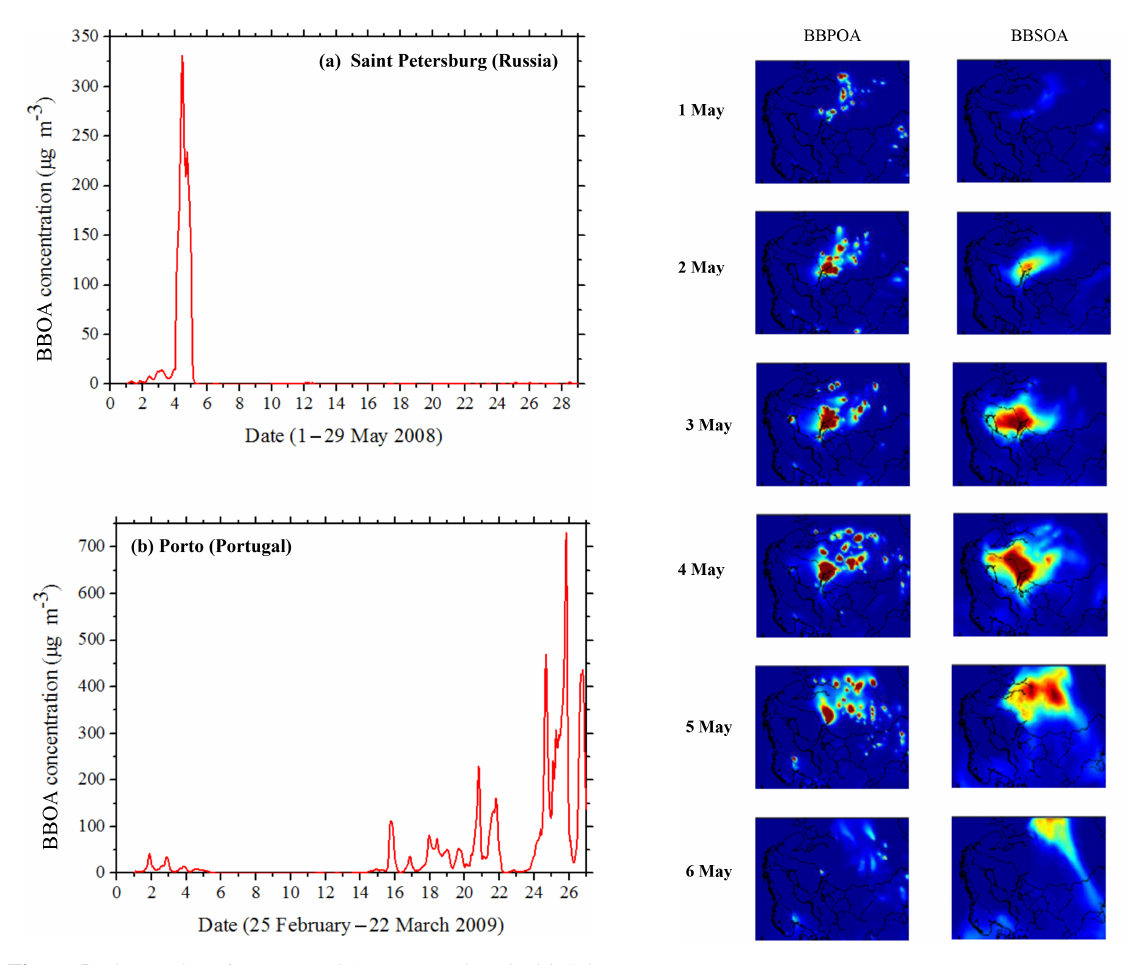
Figure 6. PMCAMx-SR predicted base case ground-level concen- trations of PM 2 . 5 BBPOA and BBSOA during 1–6 May 2008 from the Scandinavian Peninsula and